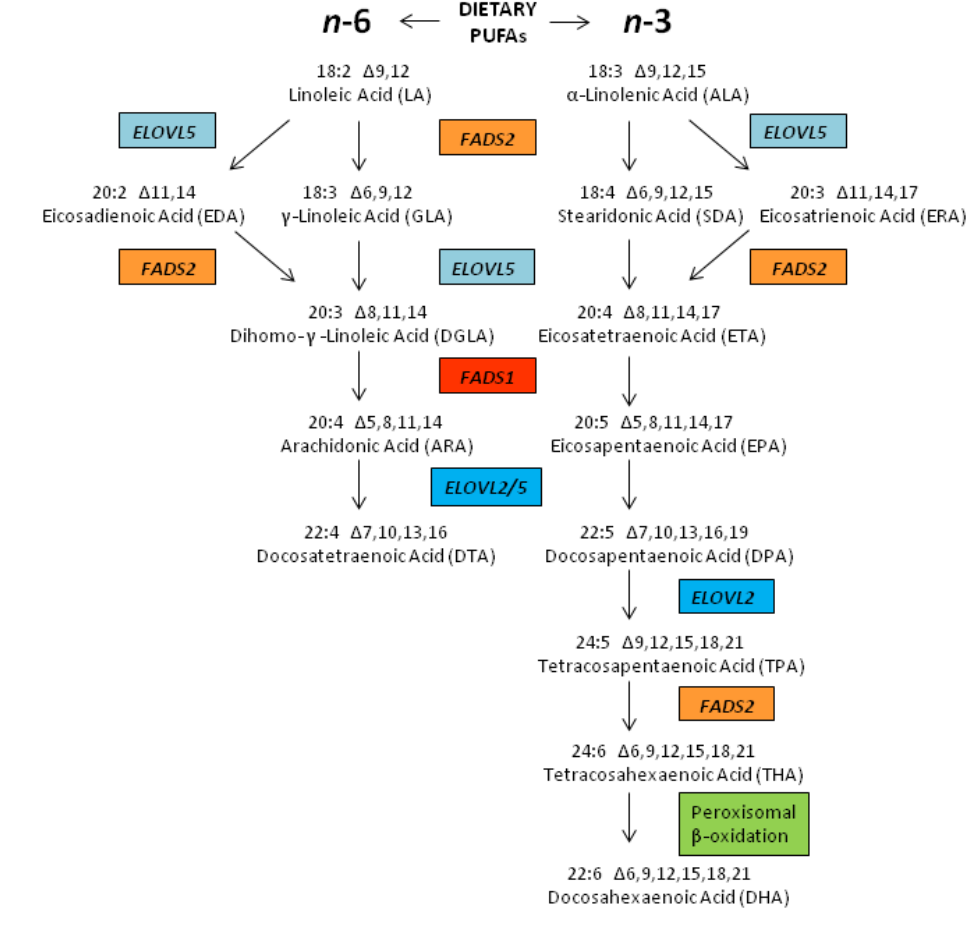
Figure 1. LCPUFA Biosynthetic Pathways. LCPUFA are derived from C18PUFAs (LA and ALA obtained from the mammalian diet) by alternate desaturation (red/orange enzymes) and elongation (blue enzymes) steps. These enzymes utilize both n -6 and n -3 substrates. n -3 LCPUFAs undergo further metabolism through a β -oxidation step (green box) to the generate